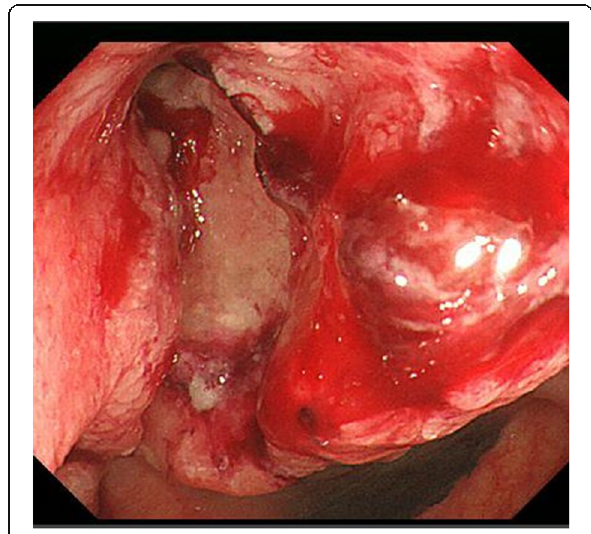
Fig. 1 Colonoscopy showed an ascending colon tumor and the colon had become severely stenotic